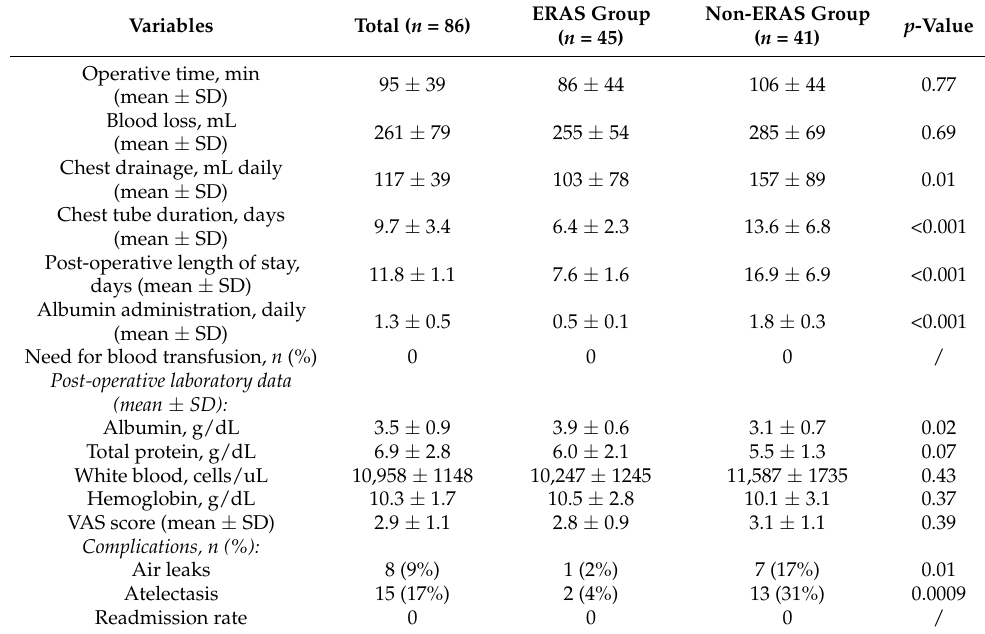
Table 3. Operative and post-operative